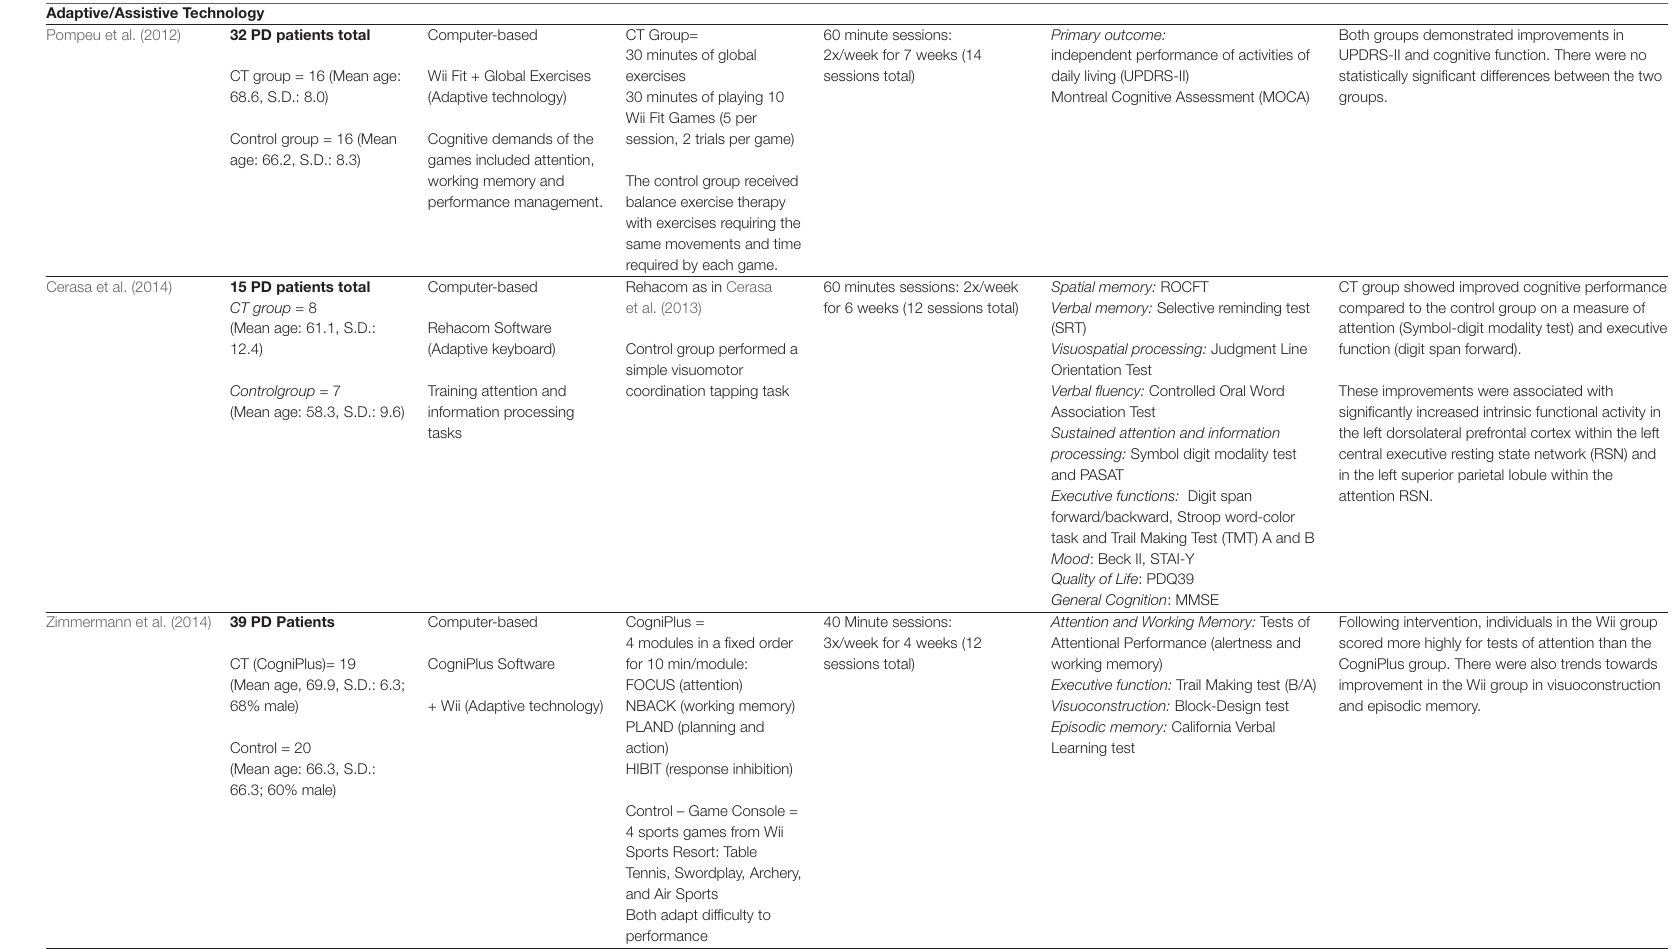
Both groups demonstrated improvements in UPDRS-II and cognitive function. There were no statistically significant differences between the two groups.